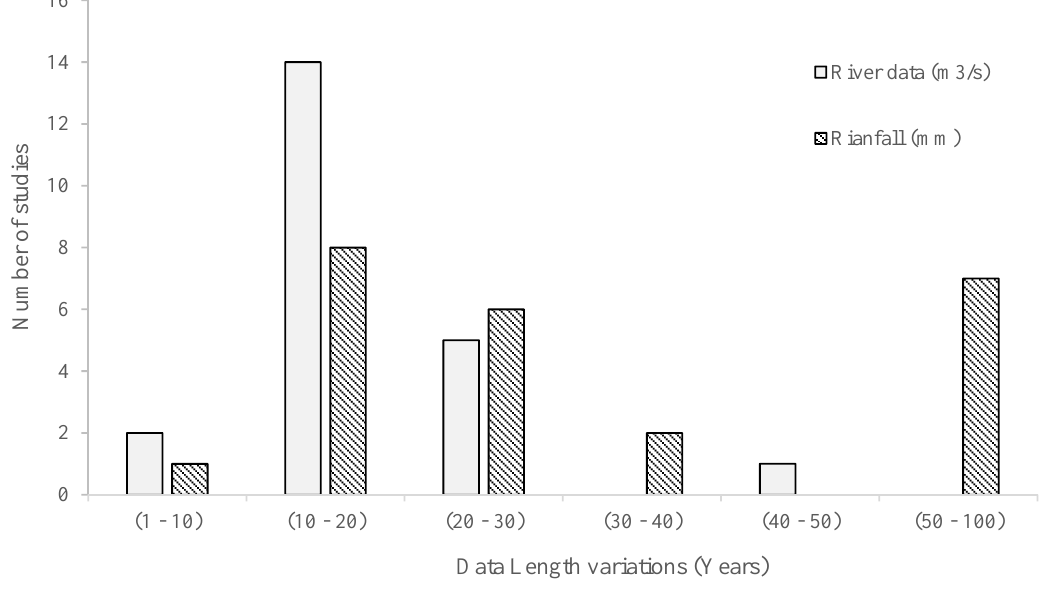
Figure 6. Rainfall and streamflow data length variation in years from previous studies in Nigeria.